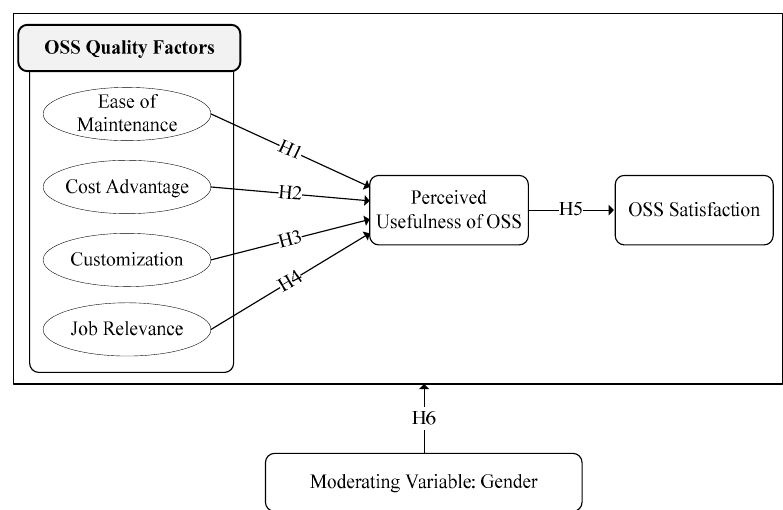
Figure 1. Research model with hypotheses.